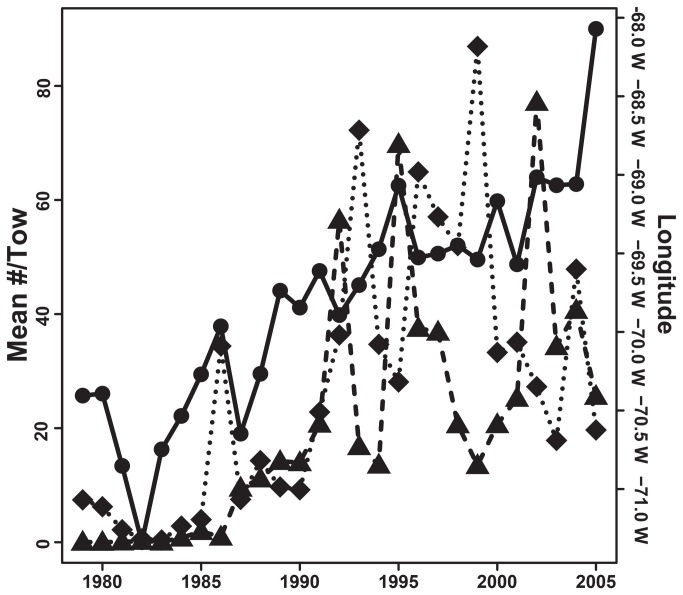
Average number of Atlantic herring/tow and position of Atlantic bluefin tuna schools.Each bluefin tuna point represents a weighted mean of surface schools (solid black circles) and is correlated with an increase in herring/tow on Georges Bank during the spring (solid black triangles) and fall trawl survey (solid black diamonds). Atlantic herring data represented as the mean herring per tow from the (National Marine Fisheries Service) autumn bottom trawl survey for survey strata on George’s Bank.